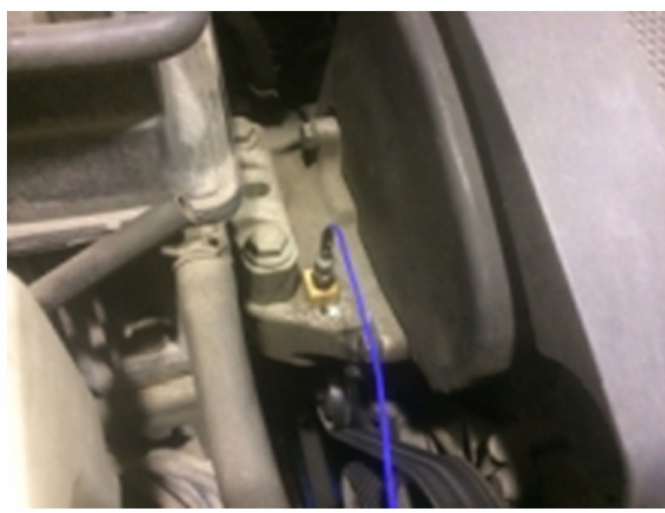
Figure 1. The sensor mounted on the upper engine